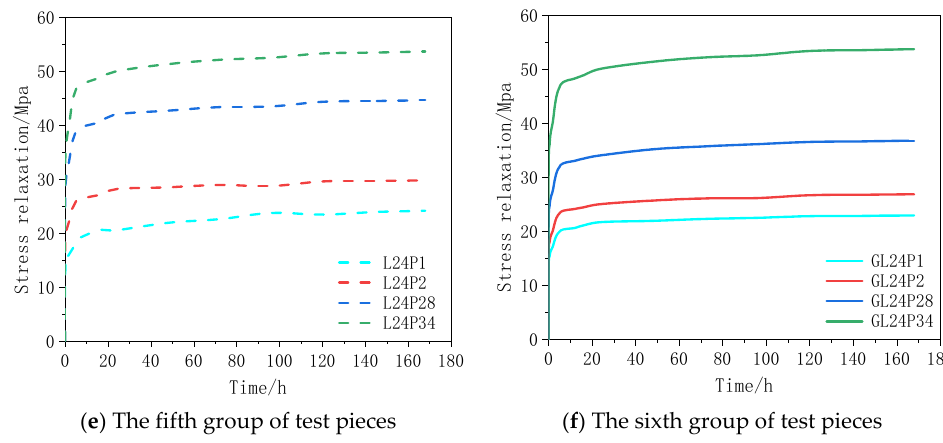
( f ) The sixth group of test pieces Figure 7. ( a – f ) Stress Relaxation loss-time relationship of CFRP cloth.